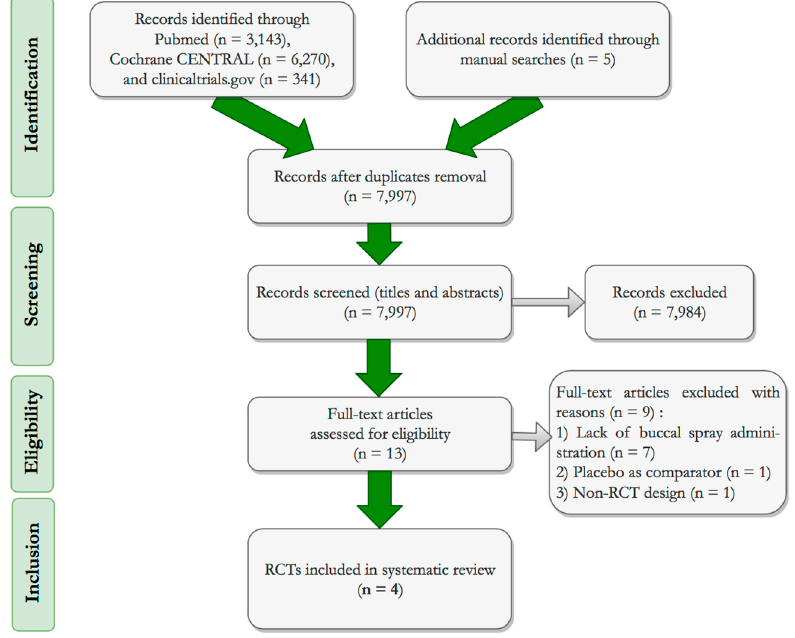
Figure 2. PRISMA flowchart [56] of the studies selection process.